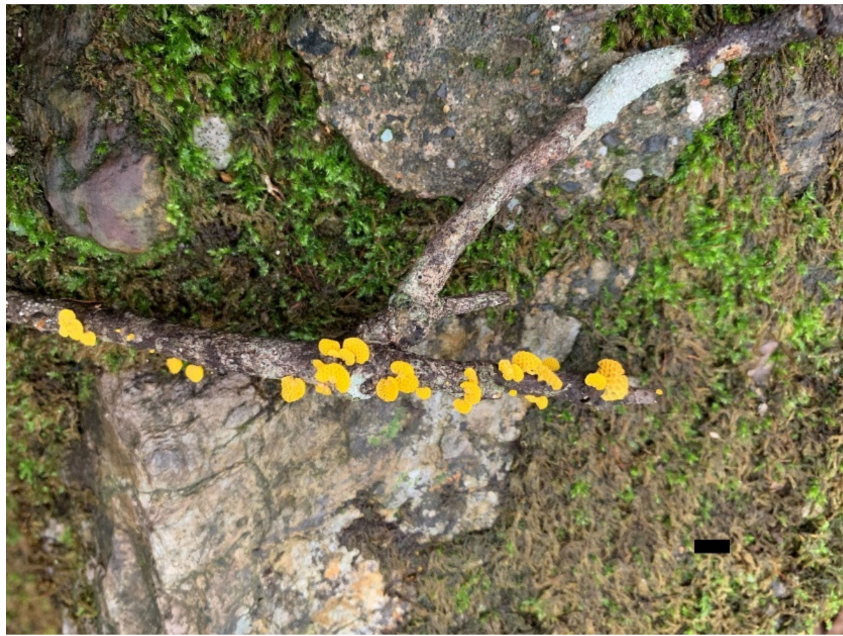
Figure 5. Fresh basidiocarps of Favolaschia brevistipitata (Holotype). Scale bar = 10 mm.